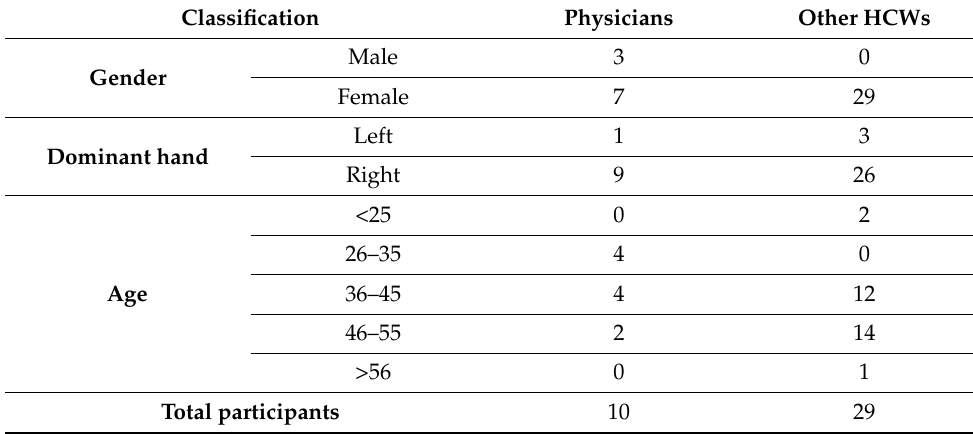
Table 1. Statistics of the survey information regarding all participants.